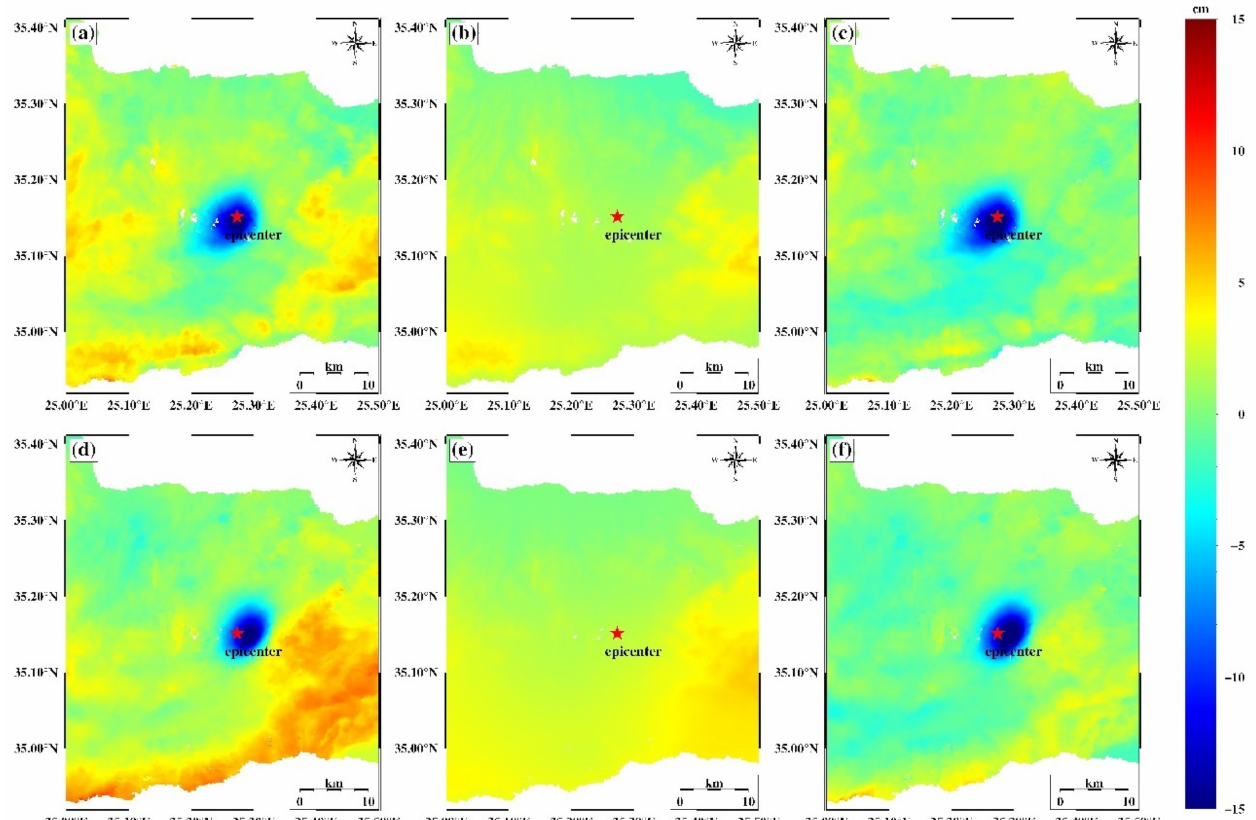
Figure 5. The GACOS corrections in D-InSAR processing. Positive value means uplift along the LOS direction. ( a ) Ascending uncorrected interferogram; ( b ) Tropospheric phase delay of the ascending interferogram calculated from GACOS; ( c ) GACOS corrected ascending interferogram; ( d ) Descending uncorrected interferogram; ( e ) Tropospheric phase delay of the descending interferogram calculated from GACOS; ( f ) GACOS corrected descending